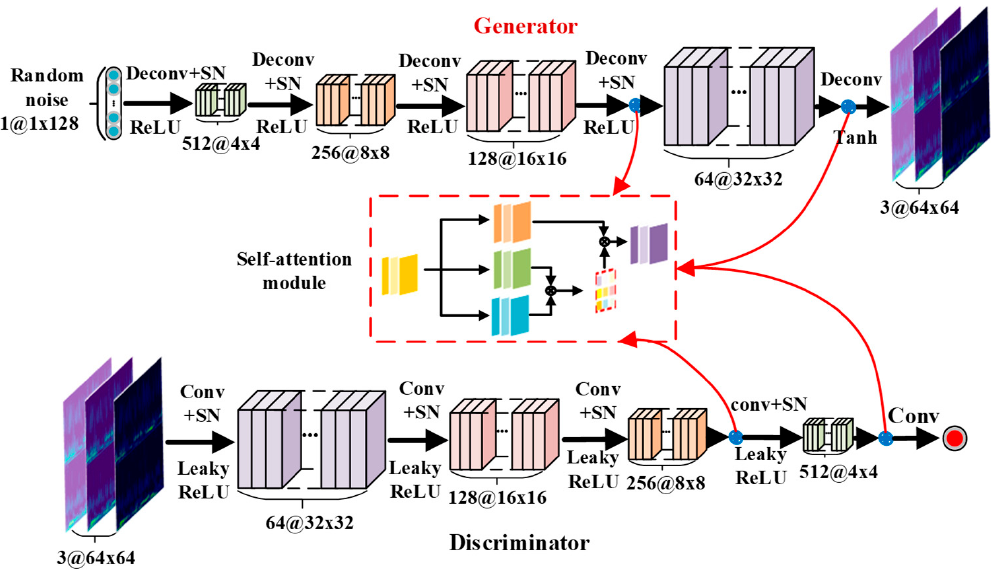
Figure 5. The basic structure of the improved DCGAN model.